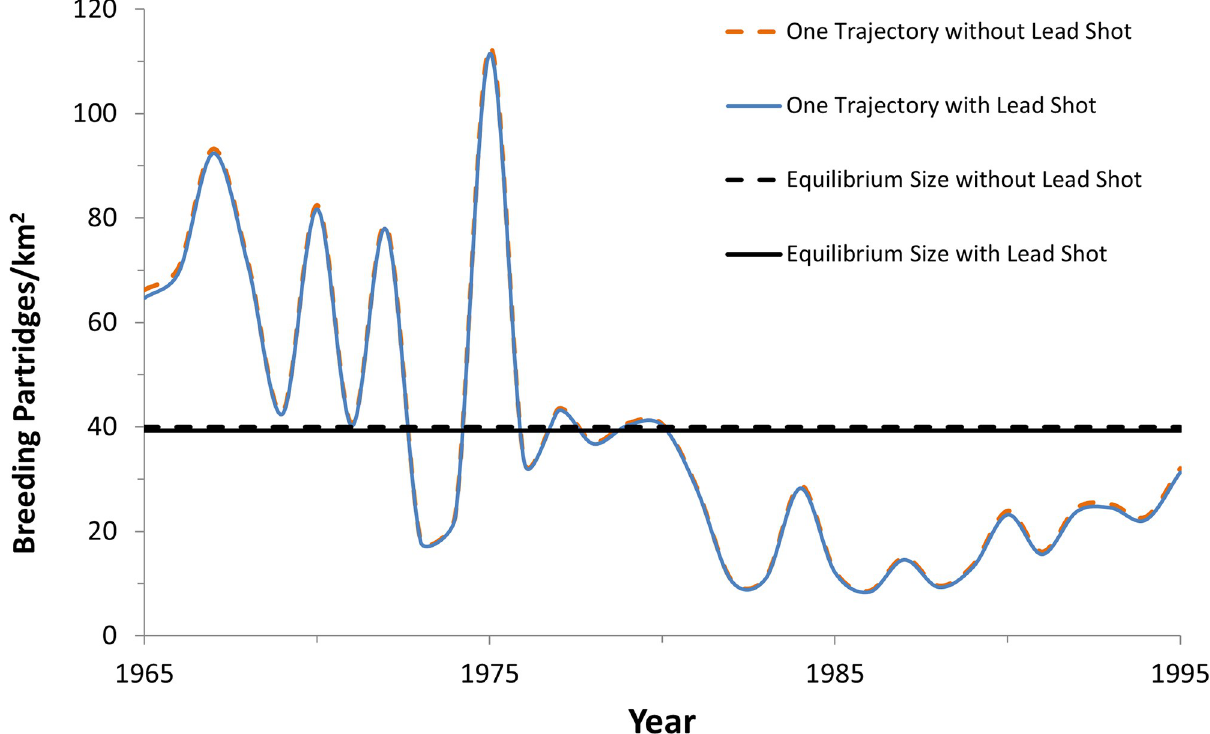
Fig 3. Modeled population trends for grey partridge with and without lead shot ingestion. Horizontal line is mean of 10,000 model iterations, representing the equilibrium population size; and the fluctuating line is an example trajectory similar to the observed declining trajectory in continental Europe [24]. Both show a barely distinguishable difference with and without lead shot. The model included reproductive effects.